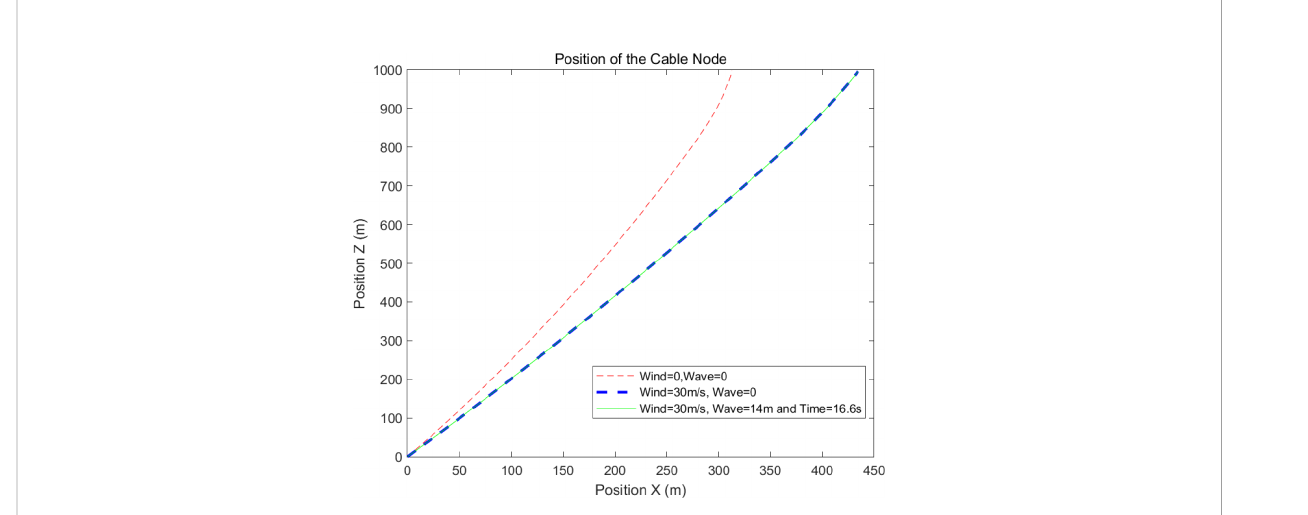
FIGURE 6 Shape of the mooring line for different weather conditions for a Nilspin cable with the snubber